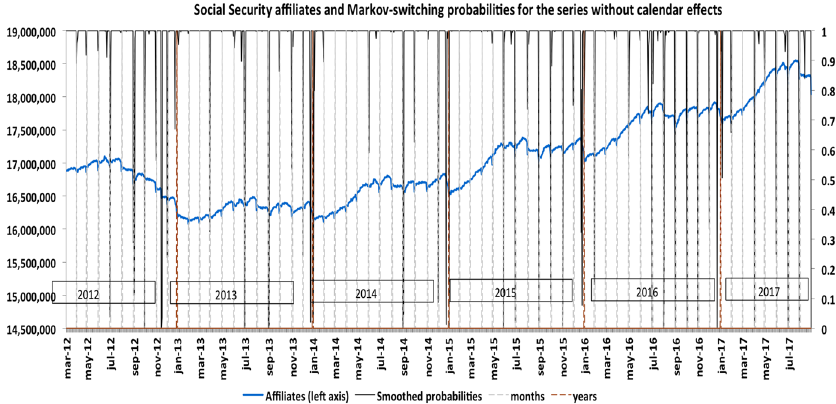
Fig.6 Number of daily social security affiliations and estimated changes in the mean of affiliations growth, over the different years after calendar and autoregressive